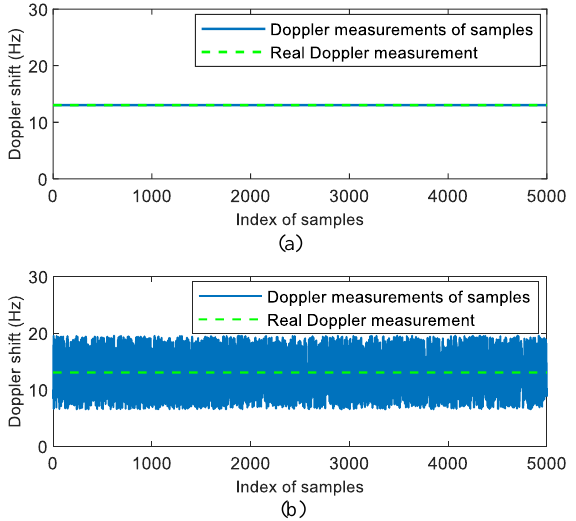
Figure 5. Doppler measurements of the samples: ( a ) the CAR method; ( b ) the A-R